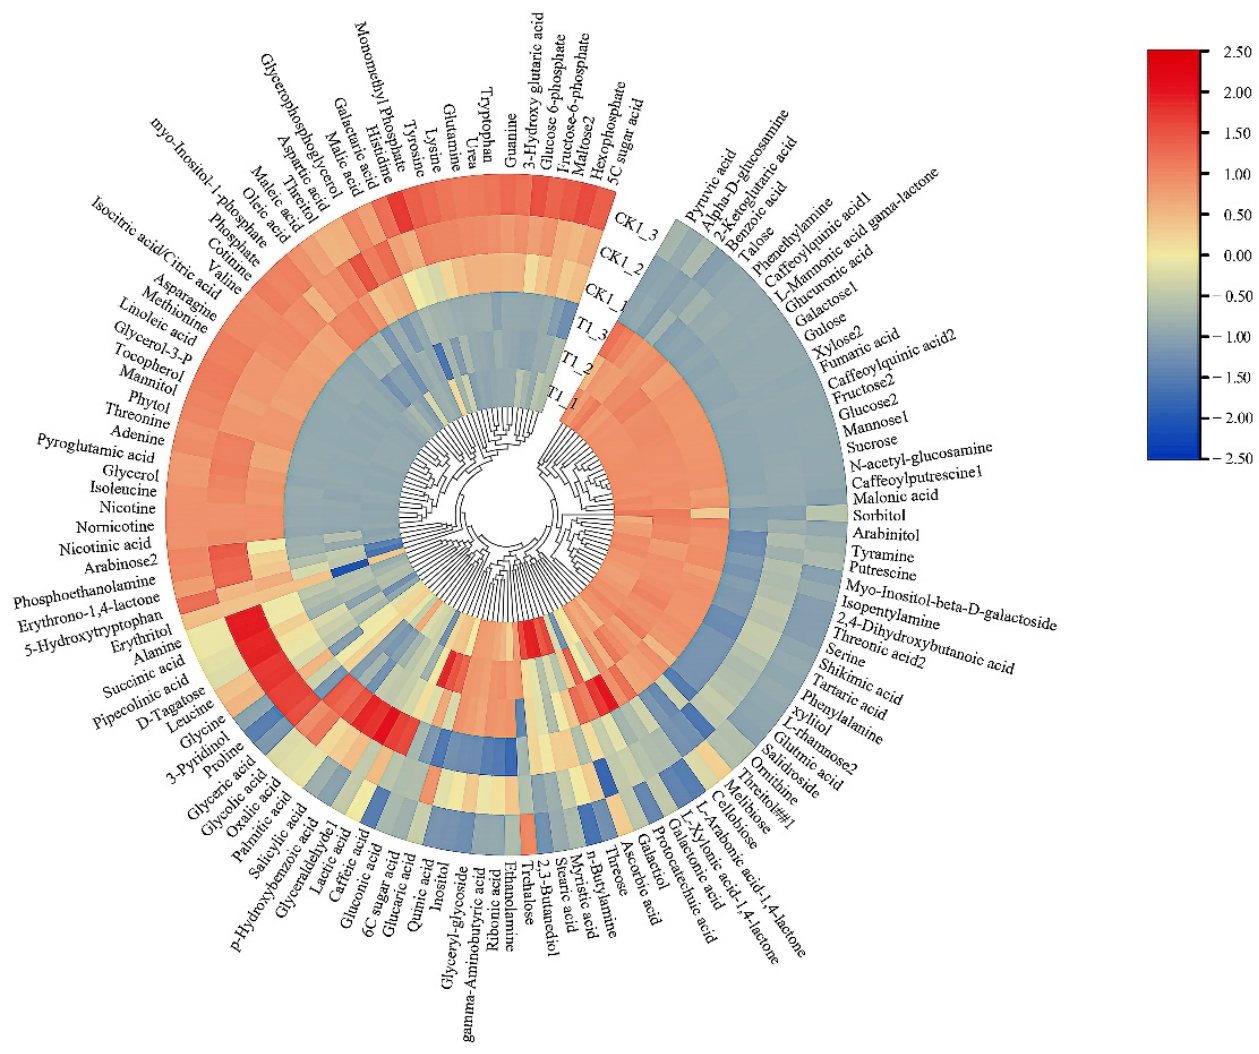
Figure 4. Heat map analysis of metabolites in tobacco seedlings ( VIP ≥ 1.10).